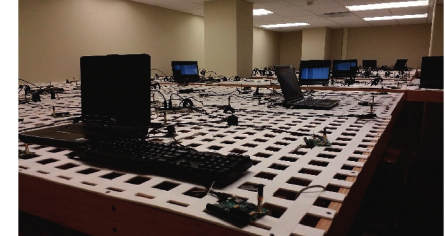
Figure 2: Node topology.